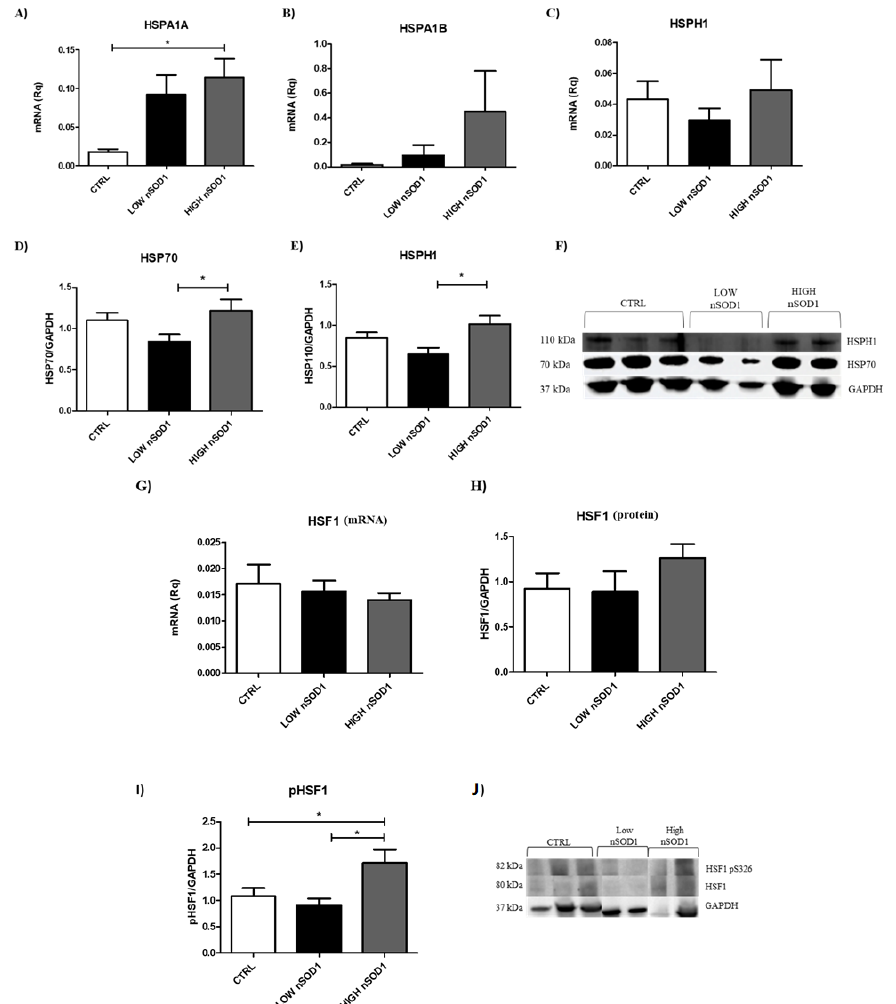
Figure 6. High nSOD1 shows an increase in heat shock proteins. Validation of HSPs. ( A – C ) RT-PCR of HSPA1A (CTRL n = 8; LOW n = 10; HIGH n = 7), HSPA1B (CTRL n = 7; LOW n = 10; HIGH n = 7) and HSPH1 (CTRL n = 13; LOW n = 9; HIGH n = 7) in PBMCs of CTRL, low-nSOD1 sALS patients and high-nSOD1 sALS patients. Data were analyzed by ANOVA (number of analyzed groups = 3) followed by Bonferroni post-test. * p < 0.05. Levels of HSPA1A and HSPA1B mRNAs are higher in patients with high nSOD1, confirming RNA-seq results, while no significant alterations are observed in HSPH1 mRNA through qPCR. ( D , E ) WB analysis for evaluating expression of HSP70s (CTRL n = 13; LOW n = 10; HIGH n = 9) and HSPH1 (CTRL n = 12; LOW n = 9; HIGH n = 11) in sALS PBMCs. Data were analyzed by ANOVA (number of analyzed groups = 3) followed by Bonferroni post-test. * p < 0.05. Levels of HSP70 and HSPH1 are higher in patients with high nSOD1 compared to those with low nSOD1. Phosphorylation of HSF1 is increased in high-nSOD1 PBMCs of sALS patients. ( F ) Representative WB membrane for HSP70s and HSHP1. ( G ) RT-PCR of HSF1 mRNA (CTRL n = 18; LOW n = 10; HIGH n = 8) in PBMCs of CTRL, low-nSOD1 sALS patients and high nSOD1 sALS patients. ( H ) WB analysis of HSF1 protein. Their levels do not change. ( I ) WB analysis for the study of HSF1 phosphorylation at serine 326 (CTRL n = 13; LOW n = 9; HIGH n = 10). Levels of phosphorylated HSF1 at S326 are higher in patients with high nSOD1 compared to those with low nSOD1 and to healthy controls. HSF1 Ps326 was normalized to total HSF1. Data were analyzed by ANOVA (number of analyzed groups = 3) followed by Bonferroni post-test. * p < 0.05. ( J ) Representative WB membrane for pHSF1 and